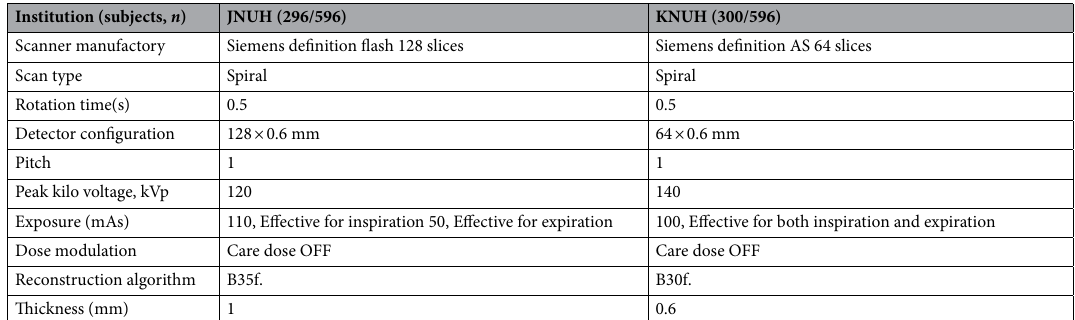
Table 4. Scanners and scanning protocols used on the COPD and non-COPD subjects. JNUH, Jeonbuk National University Hospital; KNUH, Kangwon National University Hospital; mAs,